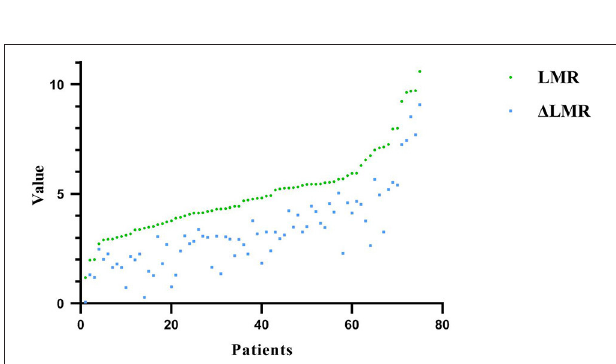
FIGURE 3 | Preoperative LMR has a similar varying trend with change of